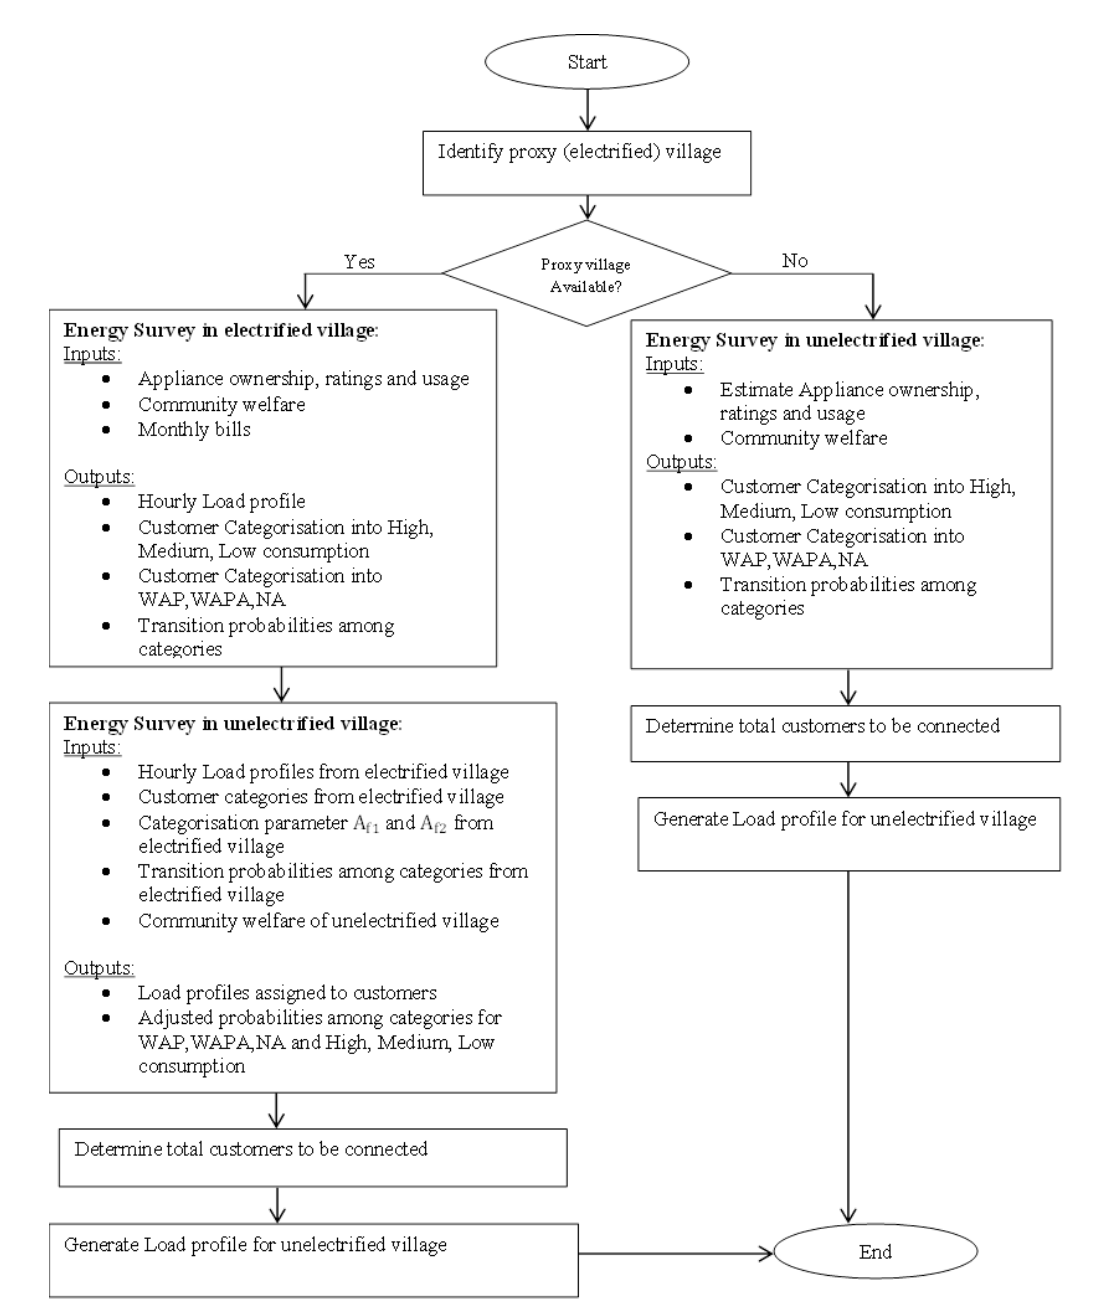
Figure 1. Improved load modelling approach framework.